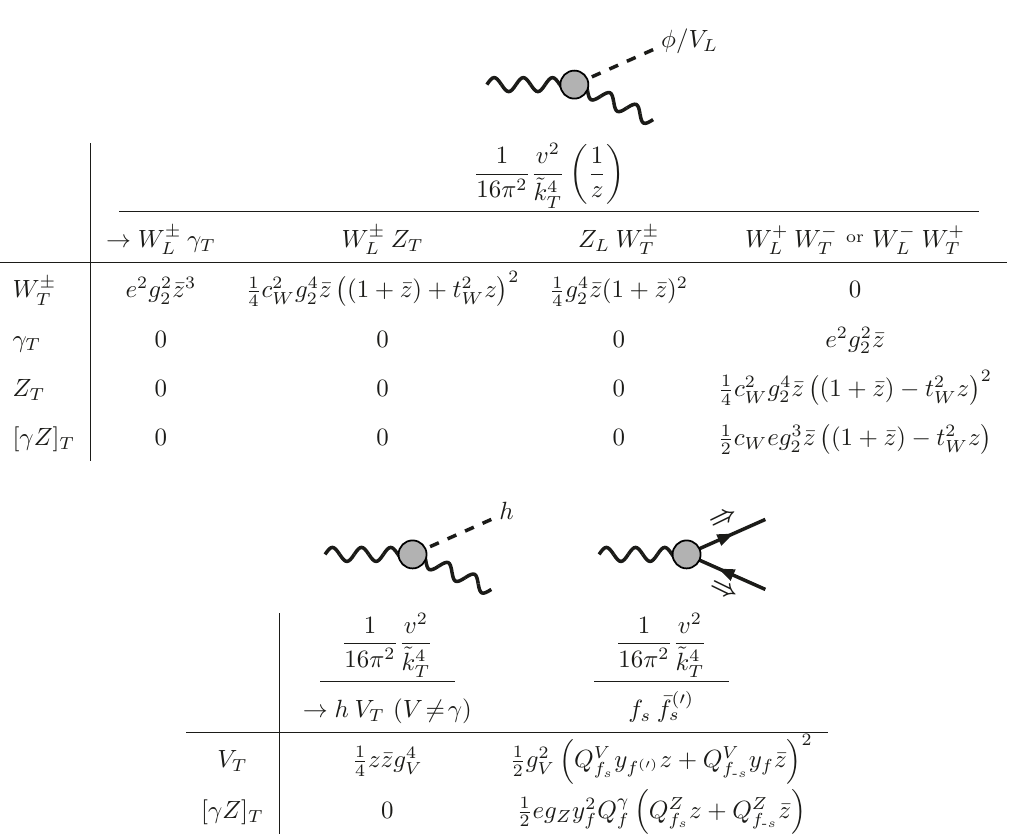
(cid:17) /dz dk 2 in the broken phase. For T P